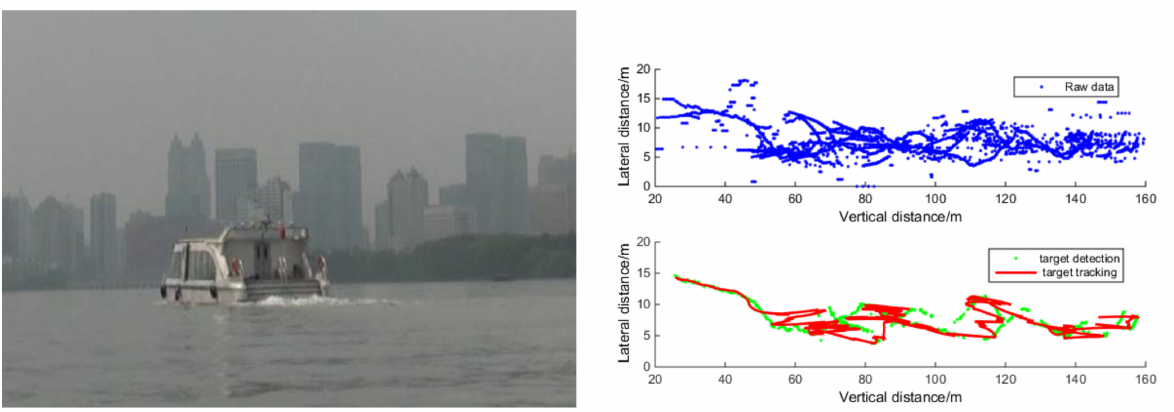
Figure 4. Radar and visual calibration